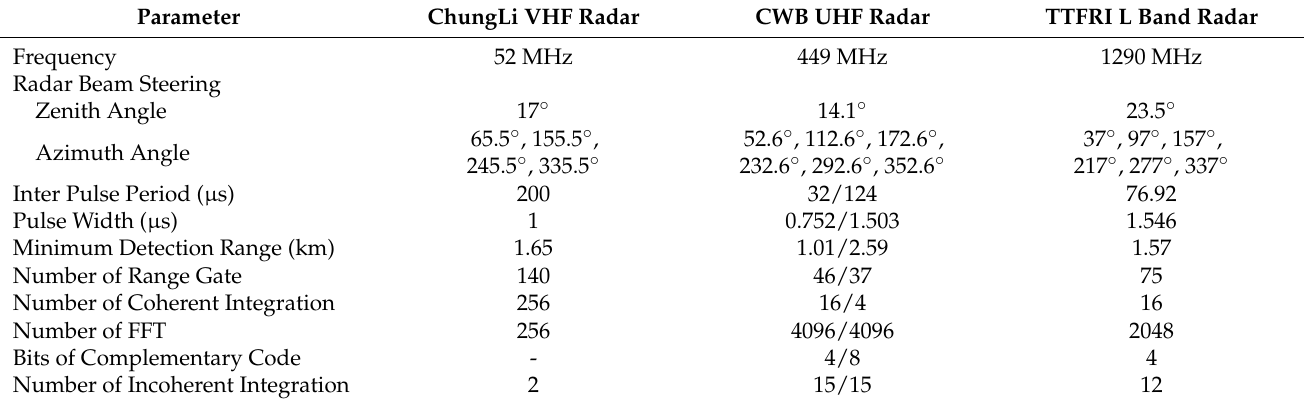
Table 1. Radar parameters of the wind profilers employed for wind comparison